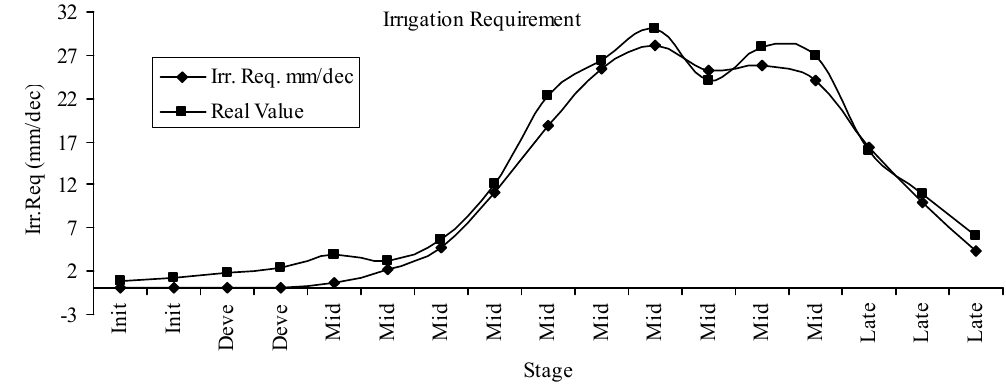
Figure 16. Amount of water depending on the stage of plant growth and used amount of water.